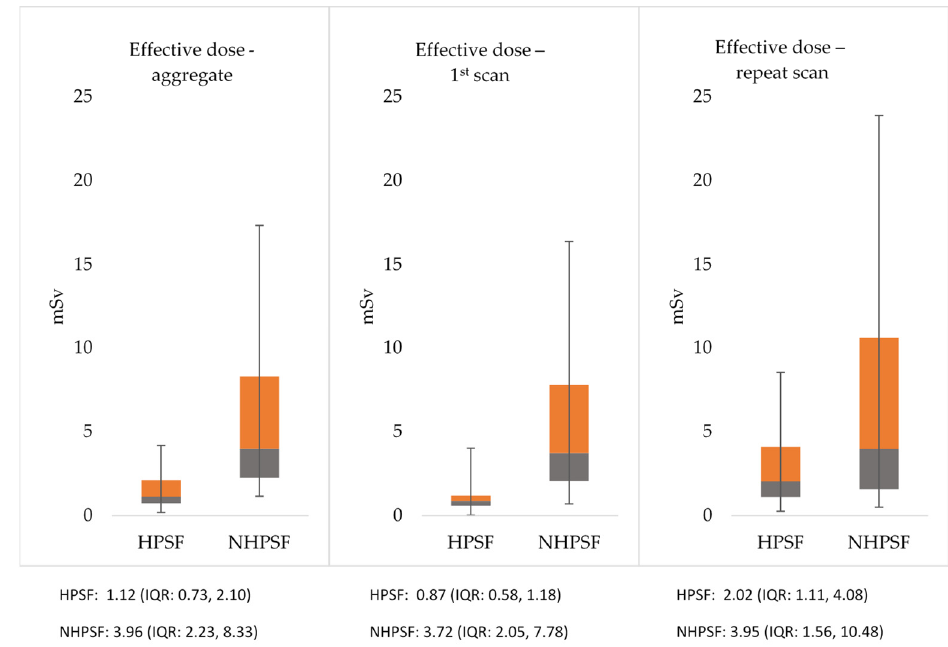
Figure 6. Radiation exposure (median, interquartile-range) for patients investigated with a HPSF and NHPSF approach. HPSF: high-pitch spiral first; NHPSF: non high pitch spiral first. All results are significant with a p -value < 0.001.